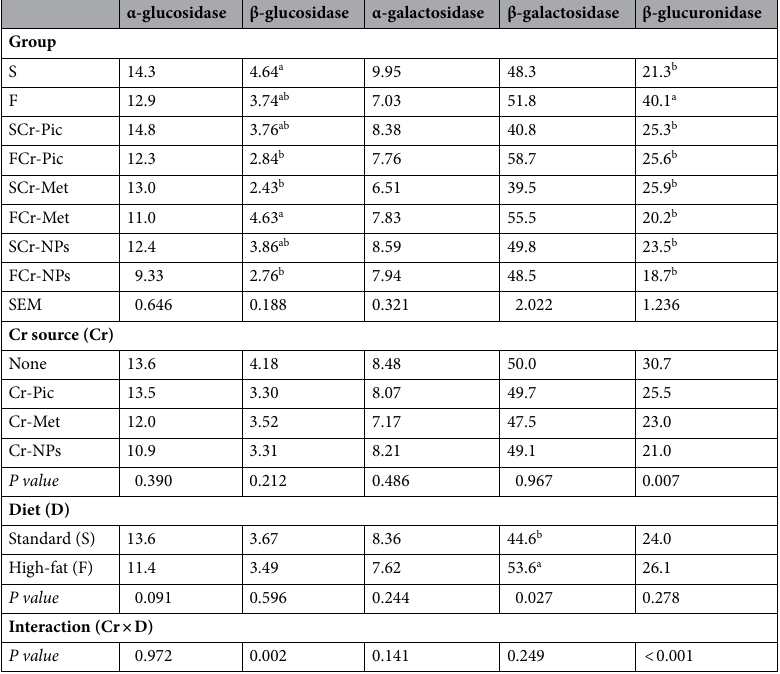
Table 5. Extracellular activity of bacterial enzymes in the caecal digesta of rats fed experimental diets, µmol/h/g digesta. S—rats fed a standard diet; F—rats fed a high-fat, low-fibre diet; SCr-Pic—rats fed diet S supplemented with 0.3 mg Cr/kg BW from chromium(III) picolinate; FCr-Pic—rats fed diet F supplemented with 0.3 mg Cr/kg BW from chromium(III) picolinate; SCr-Met—rats fed diet S supplemented with 0.3 mg Cr/kg BW from chromium(III)-methionine; FCr-Met—rats fed diet F supplemented with 0.3 mg Cr/kg BW from chromium(III)-methionine; SCr-NPs—rats fed diet S supplemented with 0.3 mg Cr/kg BW from nano- sized chromium; FCr-NPs—rats fed diet F supplemented with 0.3 mg Cr/kg BW from nano-sized chromium. a,b Means within a column with different superscript letters are significantly different ( P < 0.05); differences between groups (S, F, SCr-Pic, FCr-Pic, SCr-Met, FCr-Met, SCr-NPs and FCr-NPs) are indicated with superscripts only in the case of a statistically significant interaction Cr × D ( p < 0.05). SEM—pooled standard error of mean (standard deviation for all rats divided by the square root of the number of rats, n =